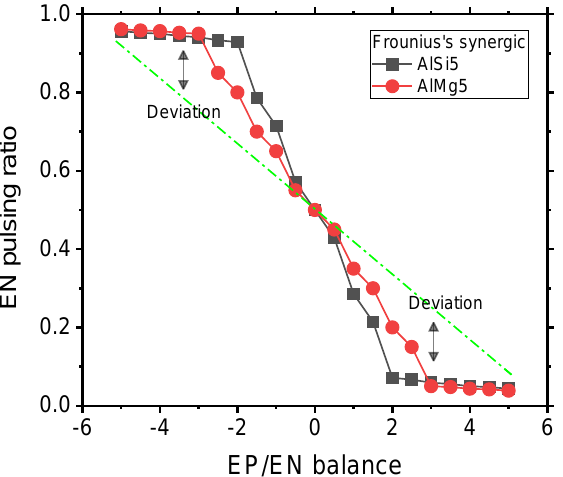
Figure 5. Relationship between the EP/EN balance and EN pulsing ratio. Table 4. EP/EN balance and recalculated EN pulsing ratio values for the AlSi5 and AlMg5 synergic line.